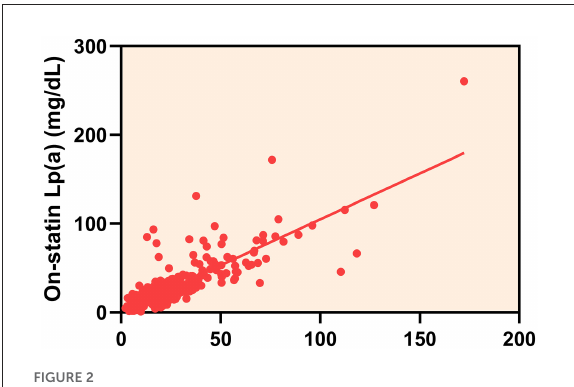
FIGURE2 The correlation between baseline and on-statin lipoprotein(a) [Lp(a)] levels. FIGURE3